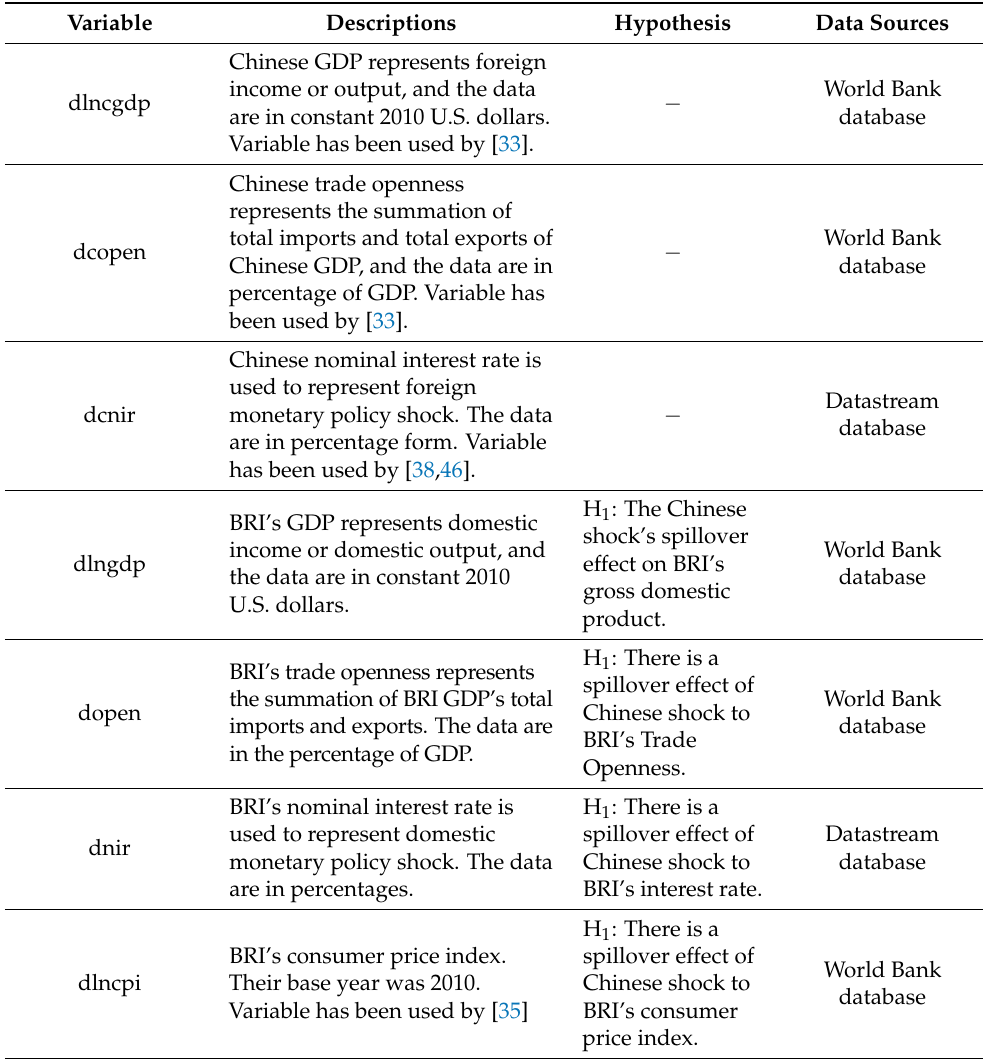
Table 1. Chinese Shock and BRI’s Macroeconomic